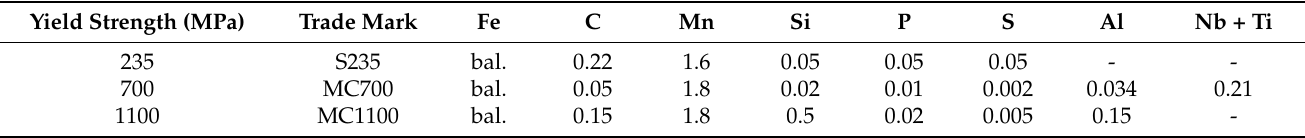
Table 1. Chemical composition of investigated steels in wt%.